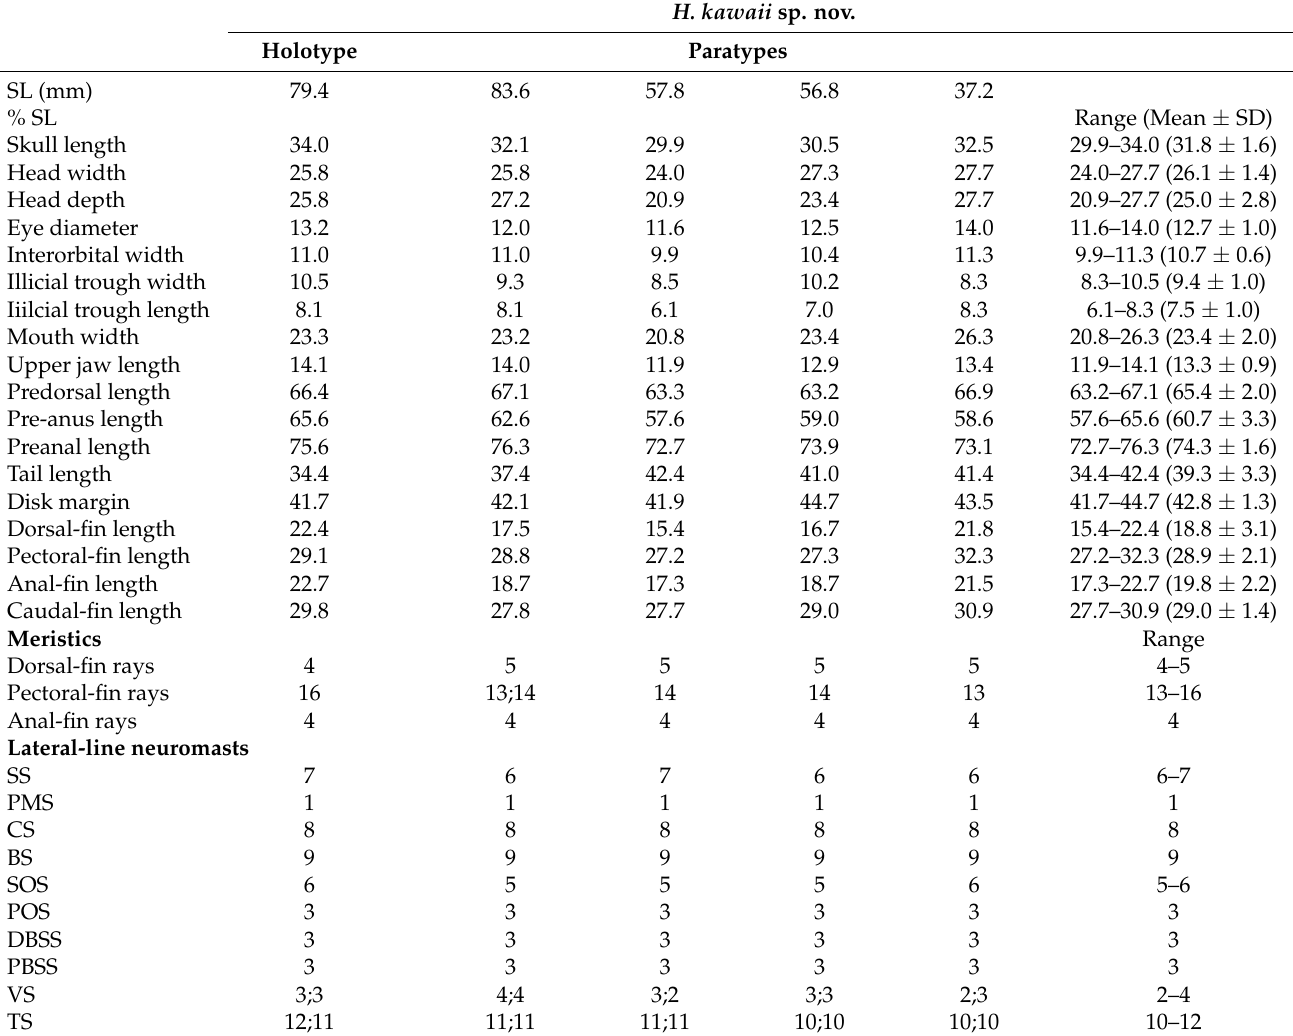
Table 6. Morphometric and metric data of three H. kawaii sp.